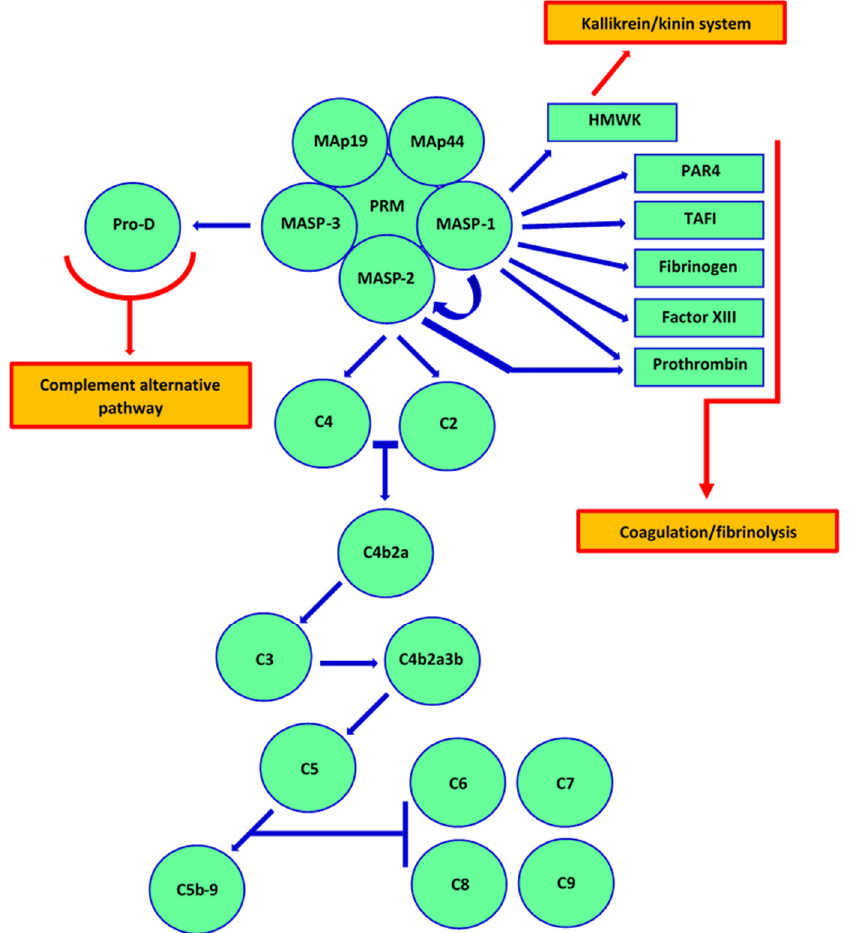
Figure 1. Activation of complement via the lectin pathway and its cross-talk with other processes. MASP-1 participates in the coagulation/fibrinolysis cascade via activation of prothrombin and factor XIII, and cleavage of thrombin-activatable fibrinolysis inhibitor (TAFI). It furthermore interacts with protease-activated receptor 4 (PAR4). MASP-1 cleaves high molecular weight kininogen as well,